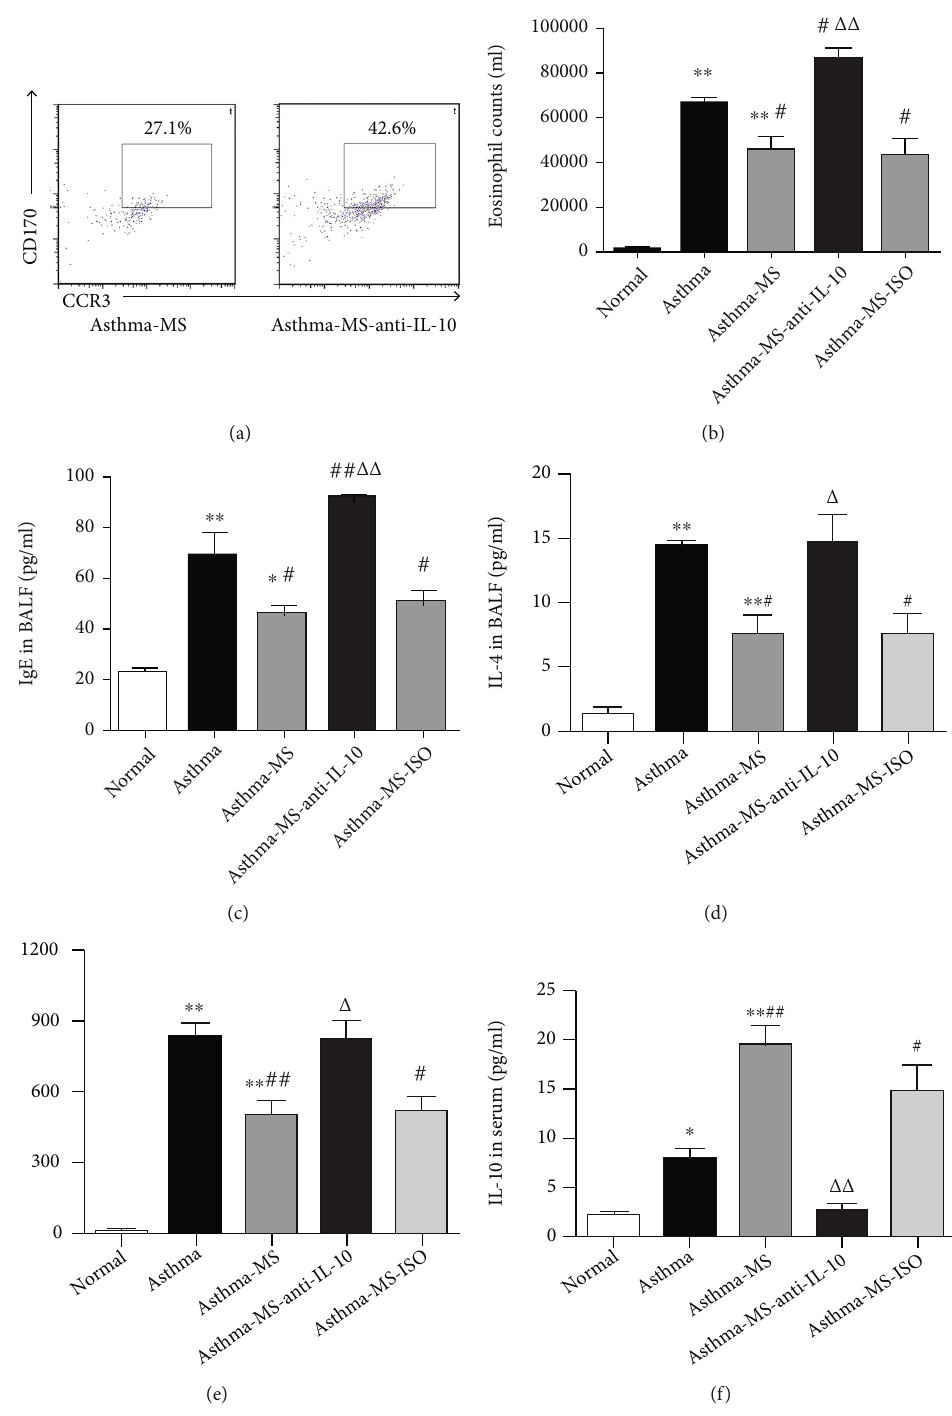
Figure 3: Anti-IL-10 partially reverses MS-induced pulmonary protection. The representative fl ow cytometry plot indicates the EOS cell percentage in one lung (a), and the data are graphed (b). The IgE and IL-4 levels in BALF were measured and analyzed by ELISA (c), and the IL-5 and IL-10 cytokine levels in serum were assessed and analyzed by ELISA (d). The data are presented in the form of the mean ± SEM ( n = 6 per group). ∗ and ∗∗ denote P < 0 : 05 and P < 0 : 01 , respectively, versus control group; # and ## denote P < 0 : 05 and P < 0 : 01 , respectively, versus asthma group; △ and △△ denote P < 0 : 05 and P < 0 : 01 , respectively, versus asthma-MS